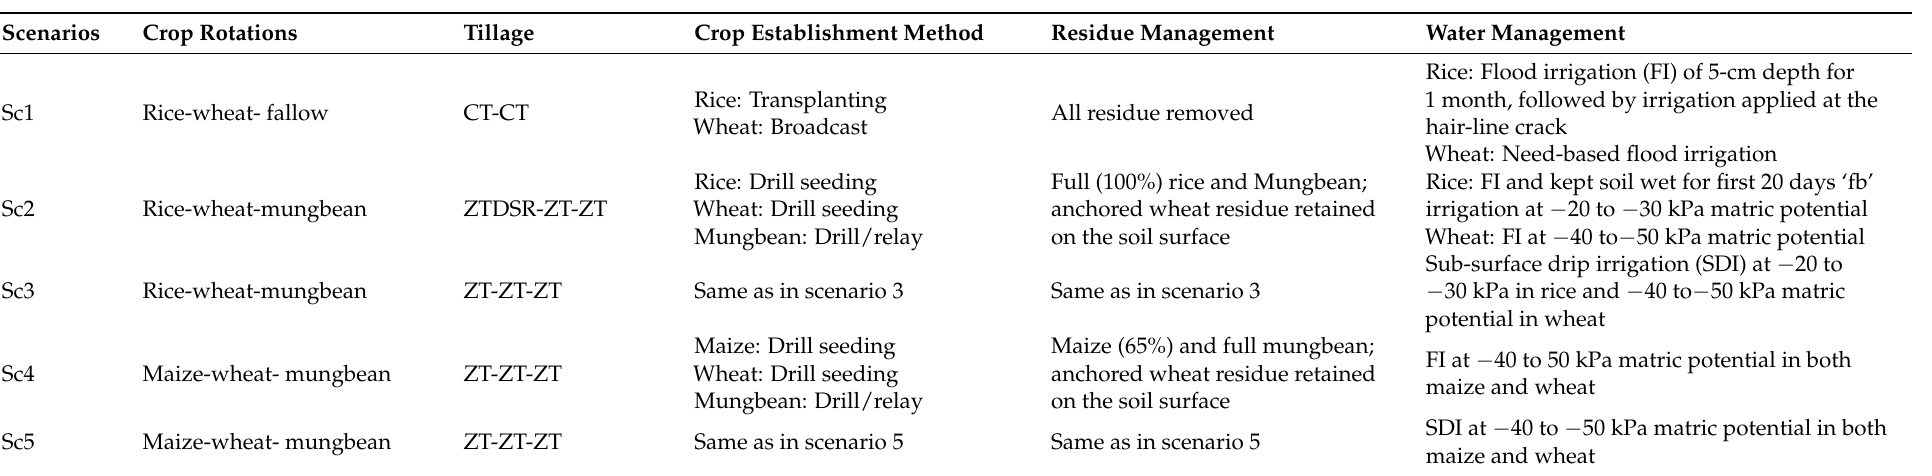
Table 1. Climate-smart agriculture (CSA)-based management scenarios comprised of crop rotation, tillage, crop establishment, and residue and water